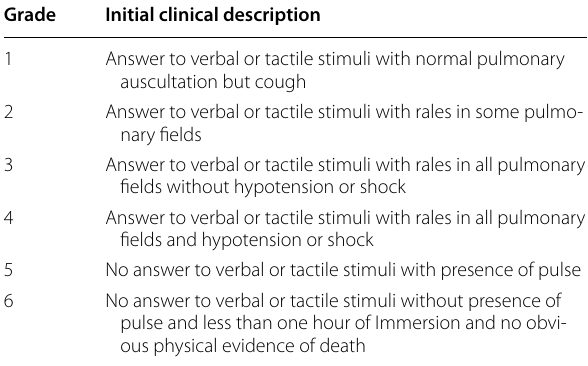
Table 1 Drowning grade derived from Szpilman et al. [2,